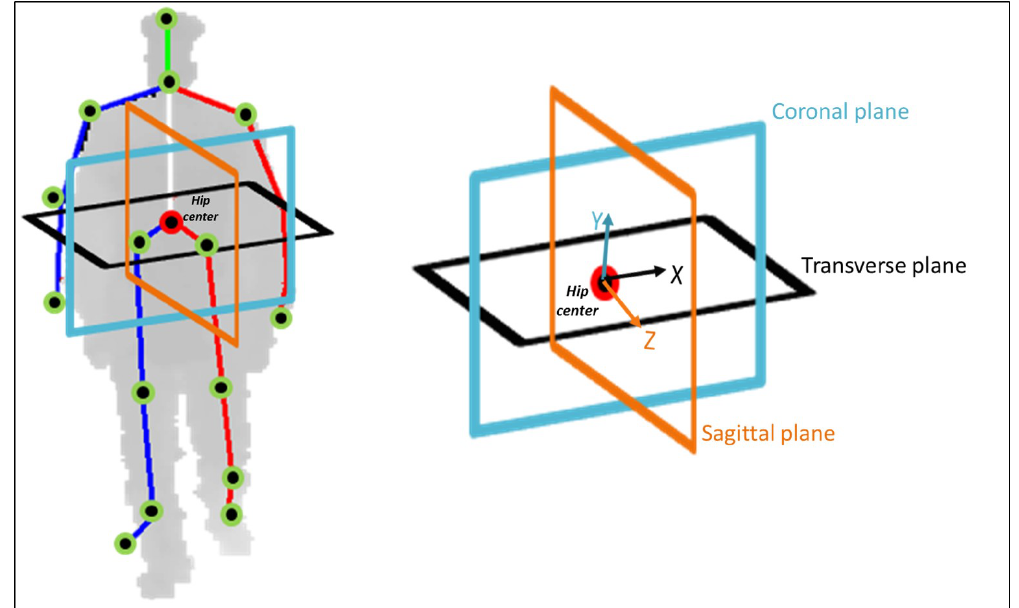
Figure 3. A schematic diagram that describes the construction of the body-attached coordinate system at the hip center joint along with the three anatomical